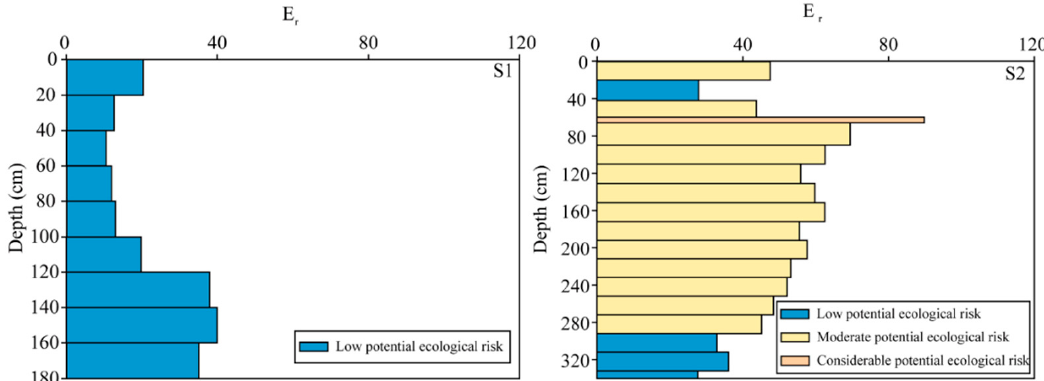
Figure 6. The ecological assessment in S1 and S2 forest soil profiles.